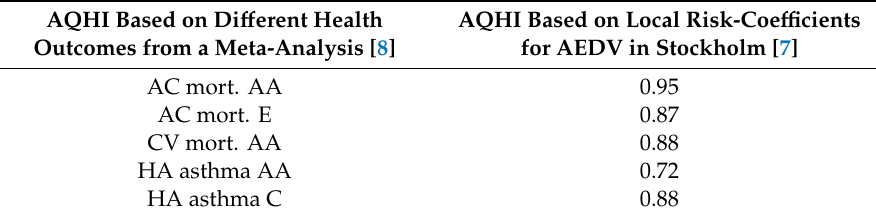
Table 4. Correlations (R-values) between AQHIs based on meta-coe ffi cients and an AQHI based on local risk-coe ffi cients for asthma emergency department visits (AEDV) in Stockholm. The calculations are based on the daily risk increases during the period of 2015–2017.